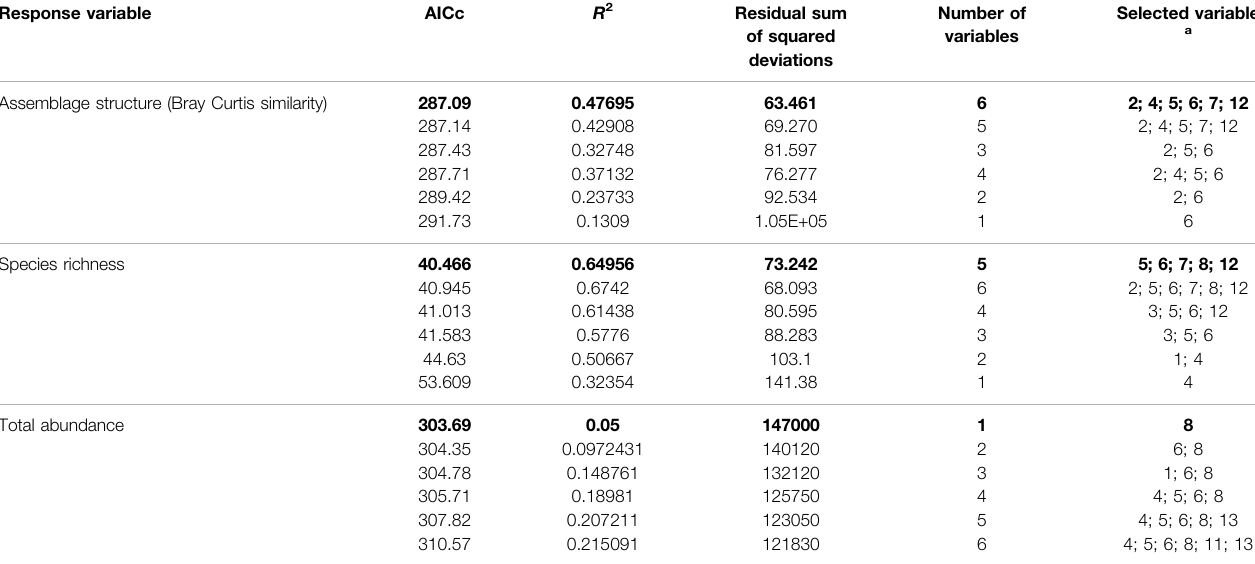
TABLE 5 | Best fi tted models per number of variables, ranked by the lowest to the highest AIC value, explaining anuran assemblage structure, species richness and total abundance in fi ve bodies of water in tropical fl ooded savanna at the Yopal Municipality (Casanare Department, Colombia). The best- fi tted model based on the value of AICc is shown in